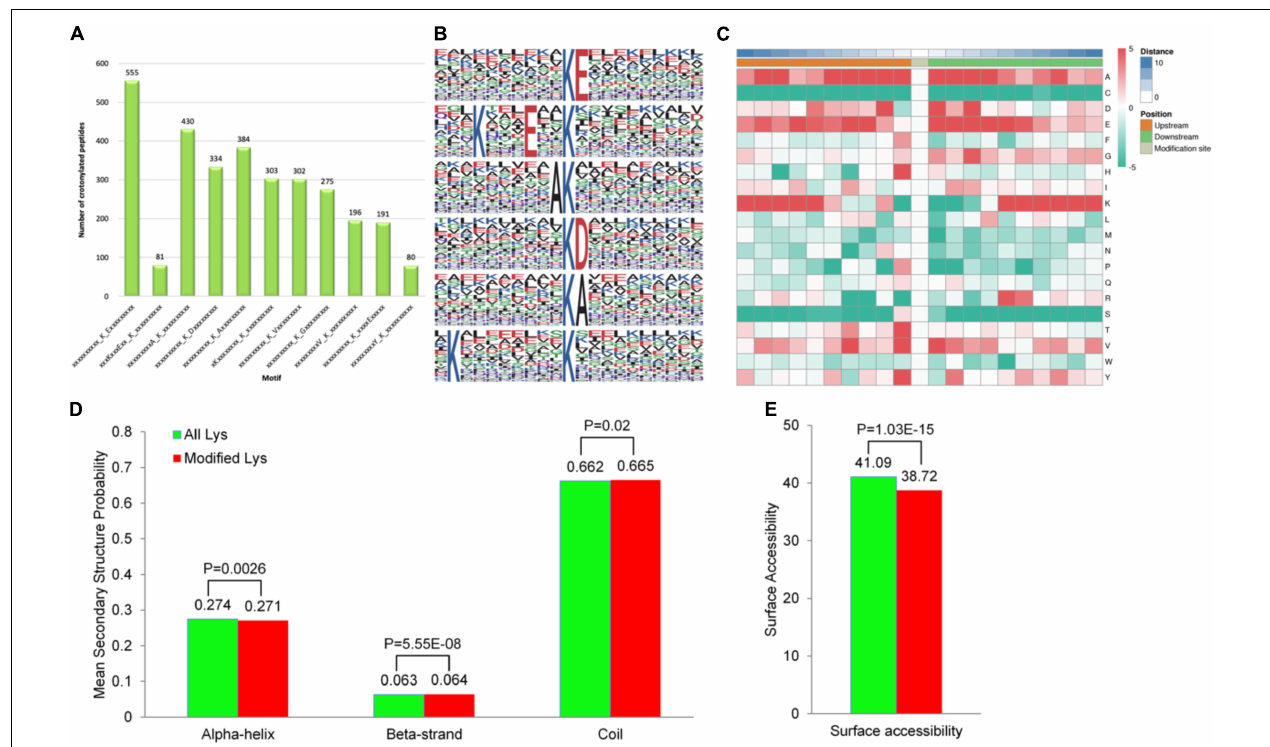
FIGURE 4 | Properties of the lysine crotonylation sites in D. huoshanense . (A) The peptides length distribution in 10 consensus sequence motifs that were significantly enriched in K residues from unique Kcr-containing sites in all. (B) Sequence probability logos of the first six enriched crotonylation site motifs around the lysine crotonylation sites. (C) Heat map of the amino acid compositions around the Kcr sites showing the frequency of different types of amino acids around this residue. Red indicates enrichment and green indicates depletion. (D) Probabilities of lysine crotonylation in different protein secondary structures (alpha helix, beta-strand, and disordered coil). (E) Predicted surface accessibility of crotonylation